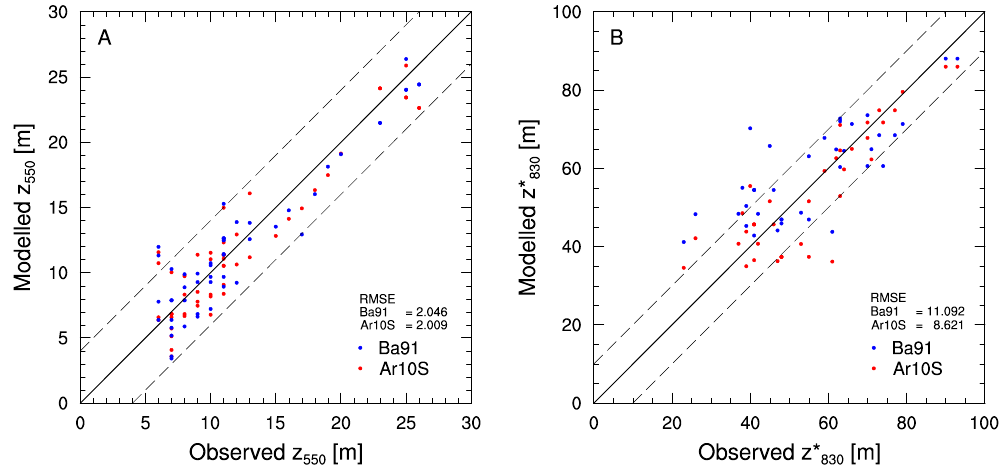
Fig. 6: Modelled vs observed depth of the ρ = 550 kg m − 3 (A) and ρ = 830 kg m − 3 (B) levels, for the updated densification expressions of Ar10S and